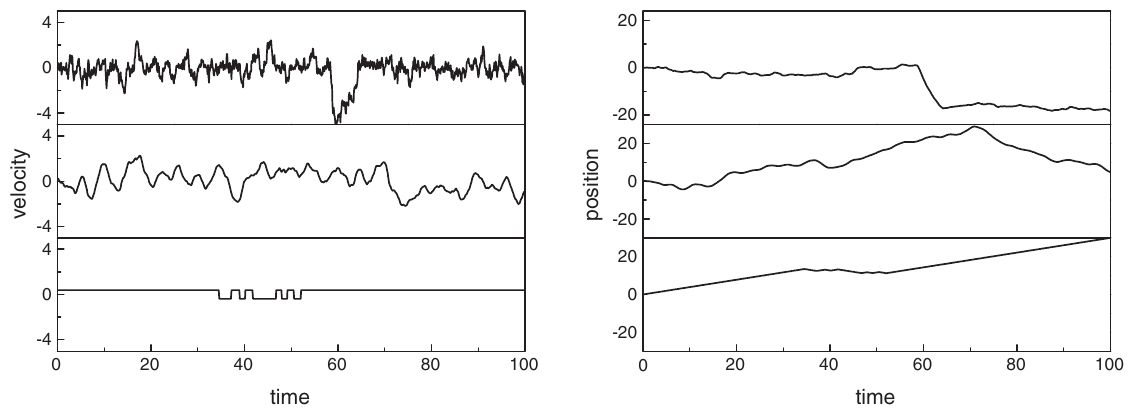
FIG. 6. Sample trajectories for the three systems discussed in Sec. III. Top: Diffusion with a nonlinear 1 =v friction force. Middle: Fractional Langevin equation with external noise. Bottom: Lévy walk alternating between (cid:2) v 0 . The left figure depicts the velocity of a single trajectory as a function of time; the right figure shows the corresponding position. The parameters were chosen such that the diffusion exponent for all three systems is ν ≃ 1 . 5 and the (dimensionless) anomalous diffusion coefficient is D ν ≃ 0 . 25 . Despite similar diffusive properties, the actual trajectories are apparently very different.